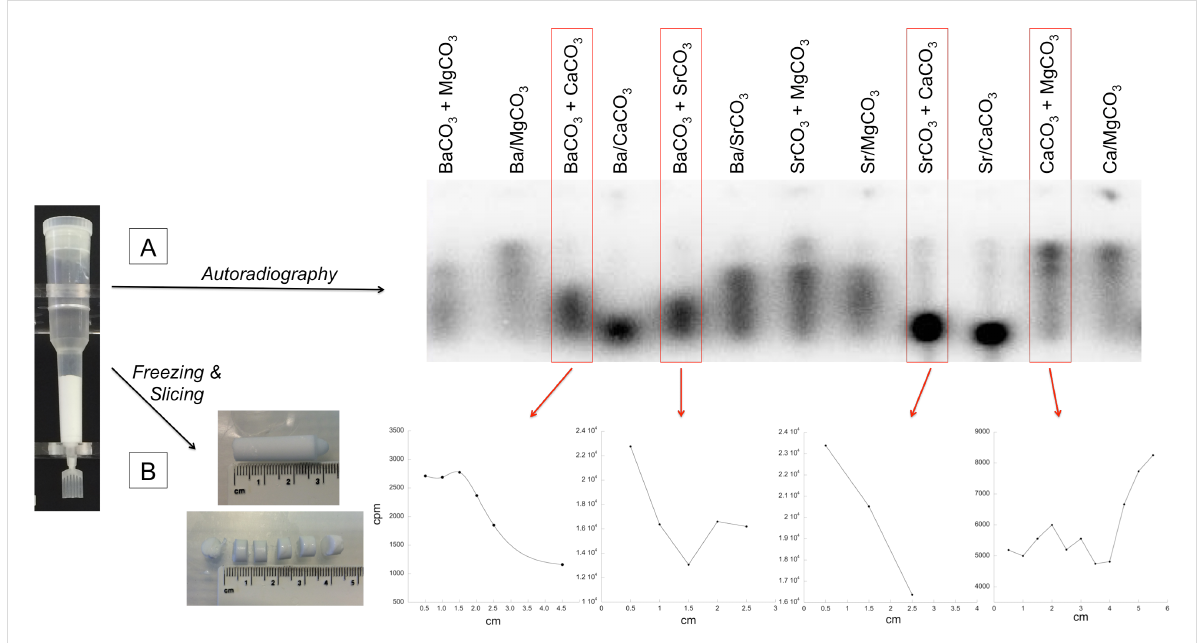
Figure 2: Co-precipitation experiments on carbonate minerals for RNA-binding competition. The precipitated column formed by two carbonates and containing radioactive RNA (left, see text for details) is exposed to a phosphorimager screen to observe RNA localization in the column (A). For each pair, carbonates are either prepared separately and then mixed together (“xCO 3 + yCO 3 ”, first column per pair), or all the ingredients are co-precipitat- ed (“xyCO 3 ”, second column per pair). Subsequently (B), columns xCO 3 + yCO 3 are frozen, cut in slices, and the radioactivity in each slide plotted versus the column height in cm. Columns for the pair Ba–Mg and Sr–Ca could not be frozen and sliced due to their high lability; their autoradiograms were profiled instead for RNA localization (data not shown). Carbonate density: CaCO 3 2.71 g/cm 3 < MgCO 3 2.96 g/cm 3 < SrCO 3 3.5 g/cm 3 < BaCO 3 4.29 g/cm 3